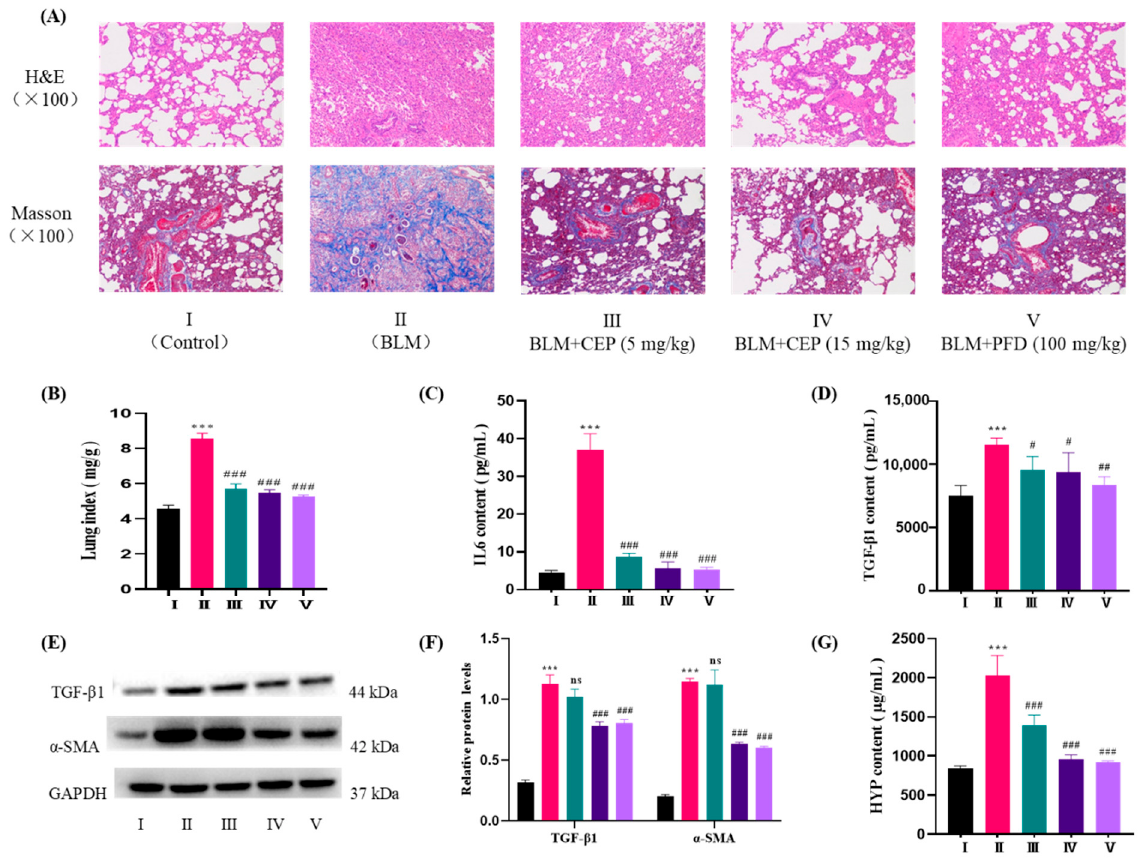
Figure 3. CEP ameliorates BLM-induced pulmonary fibrosis in rats. ( A ) representative H&E and Masson staining of lung tissues from each group; ( B ) the lung index; ( C ) IL-6 level in serum; ( D ) TGF- β 1 level in serum; ( E , F ) protein expression of TGF- β 1 and α -SMA in lung tissue; ( G ) hydroxyproline content in lung tissue. I: Control group, received normal saline by pulmonary administration for 21 consecutive days (once a day); II: BLM-induced pulmonary fibrosis group, treated with BLM (5 mg/kg) by pulmonary administration on the first day and received normal saline for 20 consecutive days (once a day); III: BLM + CEP 5 mg/kg group, treated with BLM (5 mg/kg) on the first day and received CEP by pulmonary administration for 20 consecutive days (5 mg/kg, once a day); IV: BLM + CEP 15 mg/kg group, treated with BLM (5 mg/kg) on the first day and re- ceived CEP by pulmonary administration for 20 consecutive days (15 mg/kg, once a day); V: BLM + PFD 100 mg/kg group treated with BLM (5 mg/kg) on the first day and received PFD by oral ad- ministration for 20 consecutive days (100 mg/kg, once a day). Data are presented as the means ± SD ( n = 6). *** p < 0.001 versus control group. # p < 0.05, ## p < 0.01, ### p < 0.001 and ns (no statistical difference) versus BLM group. 2.3.2. The Effect of CEP on the Histopathological Findings As illustrated in Figure 3A, hematoxylin and eosin (H&E) staining revealed a nor- mal alveoli structure of the control group without any obvious shedding of the epithelial cells in the bronchial cavity and inflammatory changes. The BLM group lung sections showed that the pulmonary architecture was significantly destroyed, including collapsed alveolar spaces, alveolar septal thickening, and heavy infiltration of the inflammatory cells. A distinct feature of pulmonary fibrosis is excessive collagen deposition in the lungs. In addition, Masson staining revealed BLM-increased collagen fiber hyperplasia in the interstitial lung spaces with the nearly complete destruction of the alveolar architec- ture. On the other hand, treatment with CEP or PFD could ameliorate the destruction, and inflammation and collagen accumulation were prominently reduced.